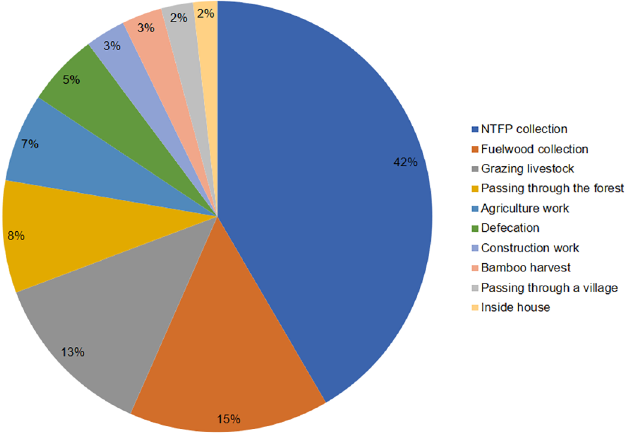
Fig 6. Activities of the victims during the attack in